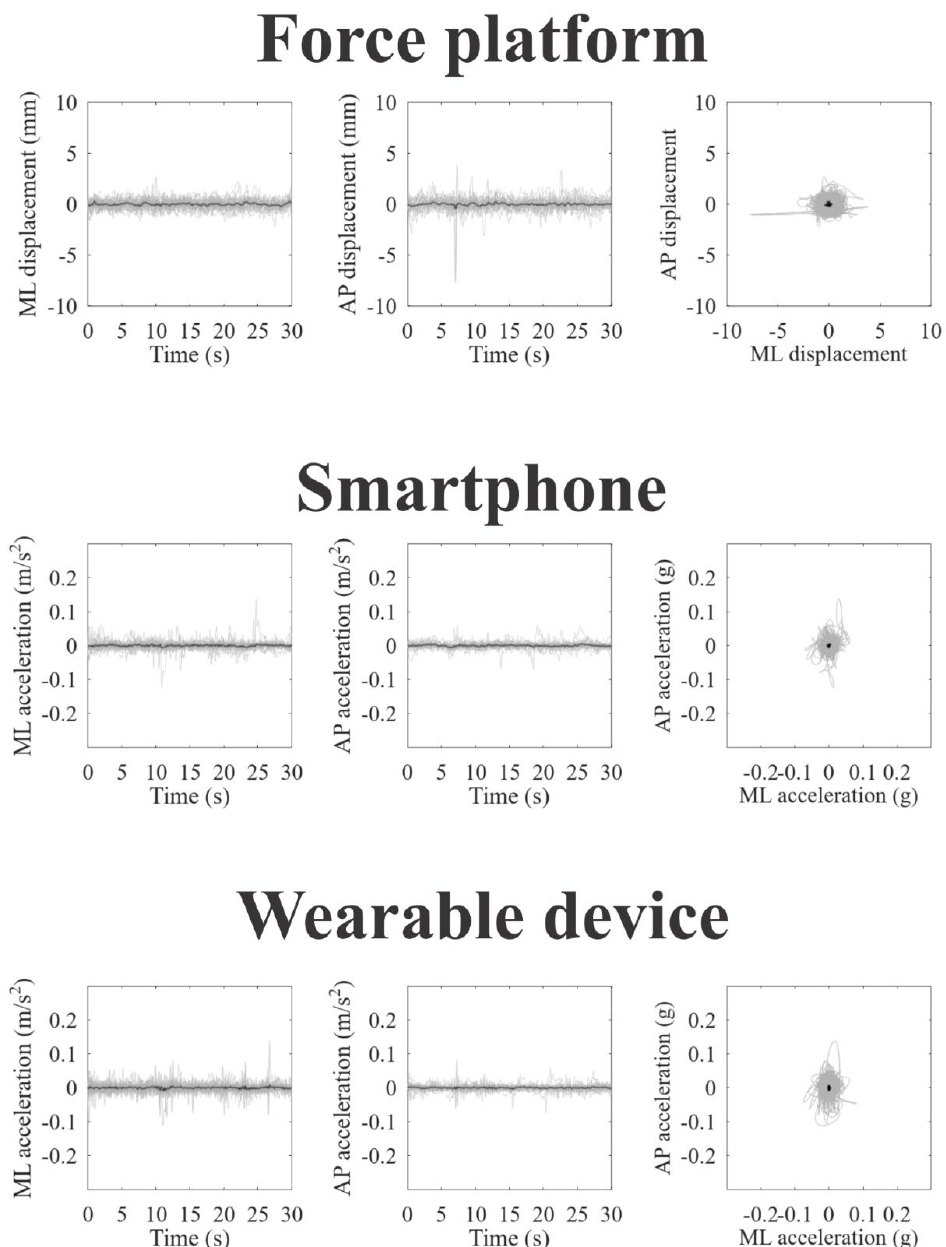
Figure 4. Static balance assessment in unipedal support condition obtained from the force platform (upper line plots), smartphone (intermediate line plots), and wearable device (lower line plots). For all instruments is shown stabilogram on the mediolateral axes (in the left); stabilogram on the anteroposterior axes; (in the center), and statokinesiogram (in the right) The black lines represent the grand mean recording, while the gray lines represent the individual recordings.